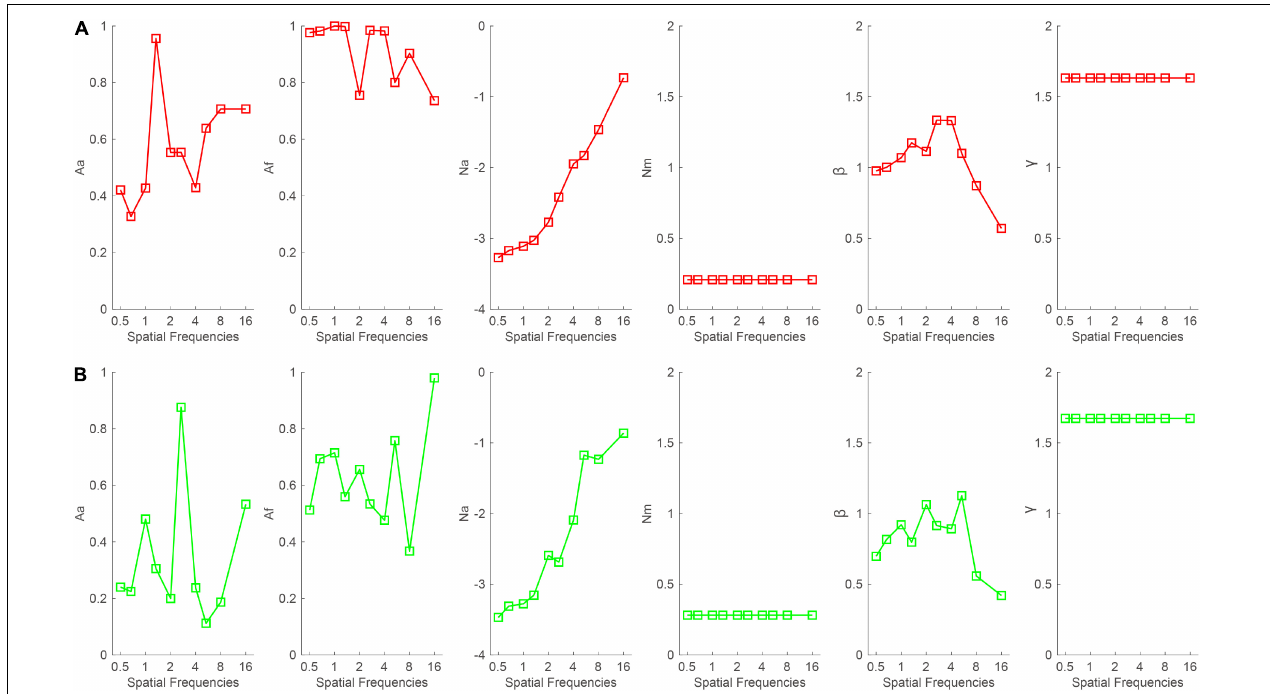
FIGURE 6 | A a , A f , N a , N m , β , and γ as a function of spatial frequencies when the (A) good or (B) bad eye was considered as the standard eye, respectively.